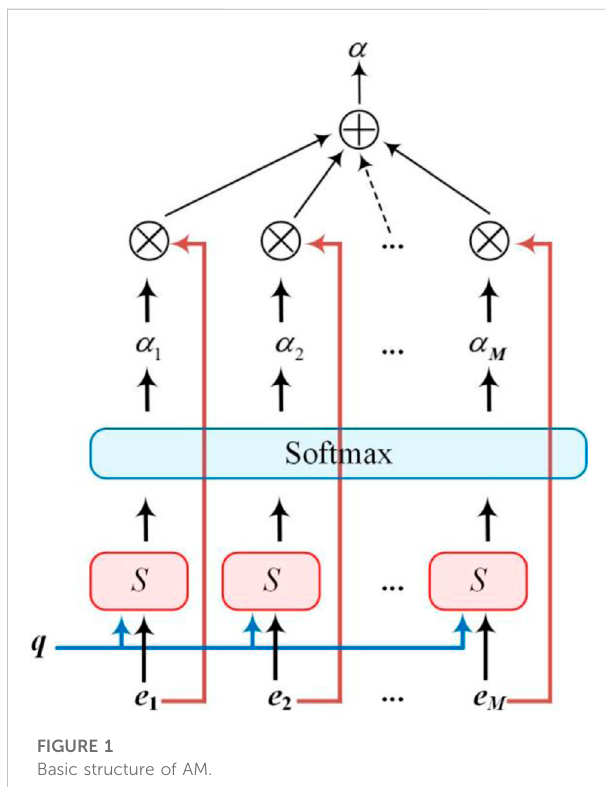
FIGURE 1 Basic structure of